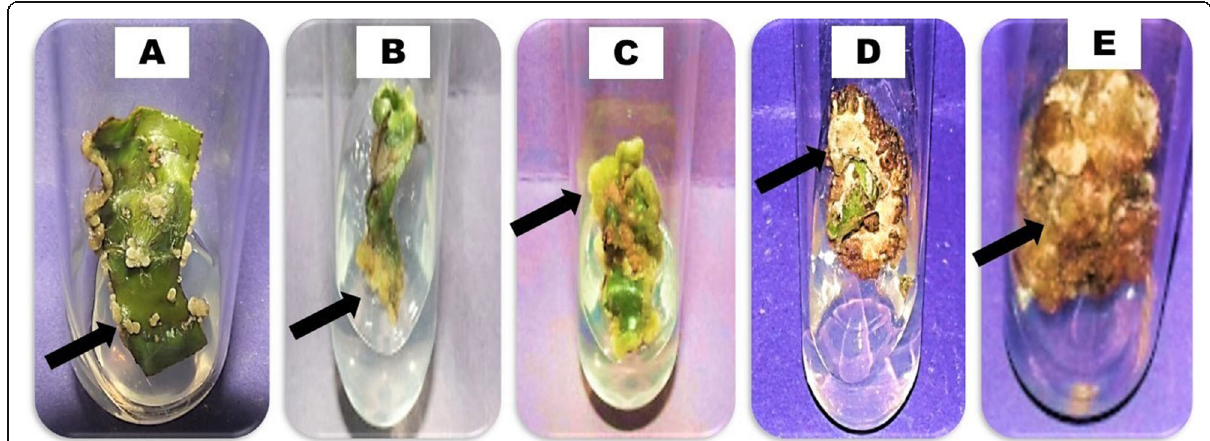
Fig. 1 In vitro callus induction at different time intervals in CP from leaves explant. a Initiation of callus. b After 2 weeks. c After 4 weeks. d After 6 weeks. e After 8 weeks